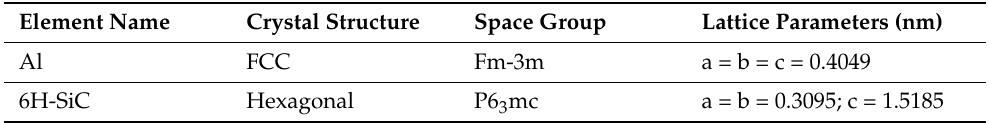
Figure 1. SiC(0001)-Si/Al(001) tensile model structure given as an example: ( a ) Al, ( b ) SiC. Al-atoms are colored yellow, C-atoms are colored red, and Si-atoms are colored blue. Table 1. Crystal structures of 6H-SiC and Al. Table 2. Orientation relationships of the SiC/Al interface systems studied in this work.